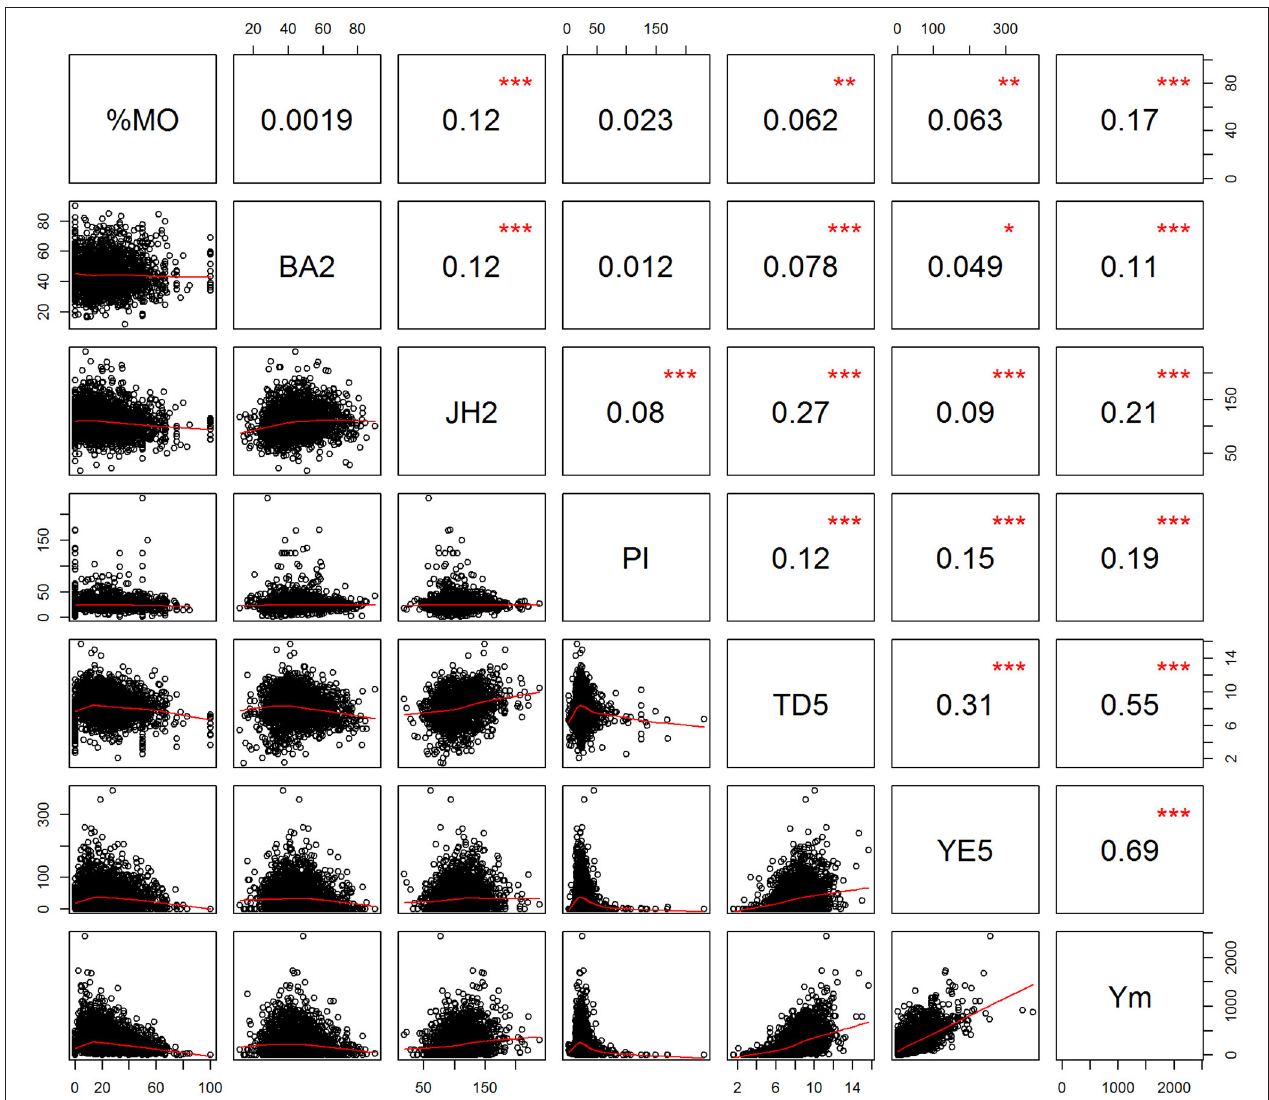
FIGURE 2 | Scatterplot (lower diagonal) and phenotypic Pearson product-moment correlation (upper diagonal) for selected traits. Proportion of Monilia infected pods (%MO), branch angle (BA2), Jorquette height (JH2), pod index (PI), trunk diameter at year five (TD5), yield efficiency at year five (YE5), mean yield ages 2–7 (Ym). Significance levels of are determined by: *** p < 0.001; ** p < 0.01; * p < 0.05.